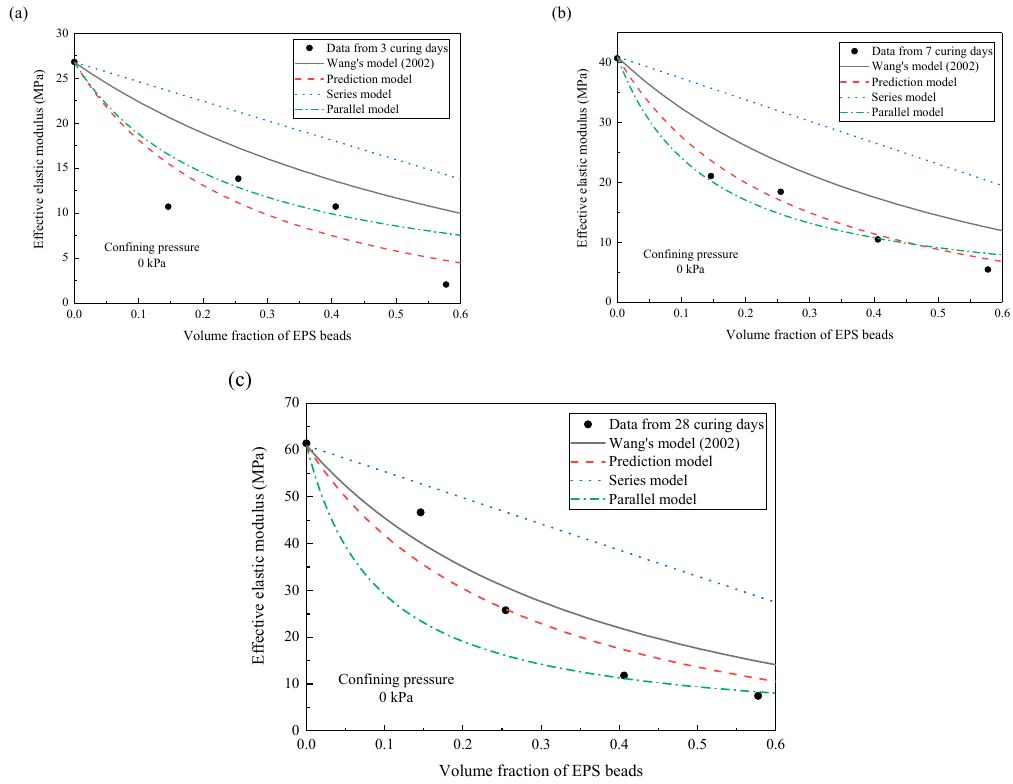
Figure 5. Comparison of effective elastic modulus predicted by models with experimental data from Wang et al. [11]. ( a ) 3 curing days. ( b ) 7 curing days. ( c ) 28 curing days.